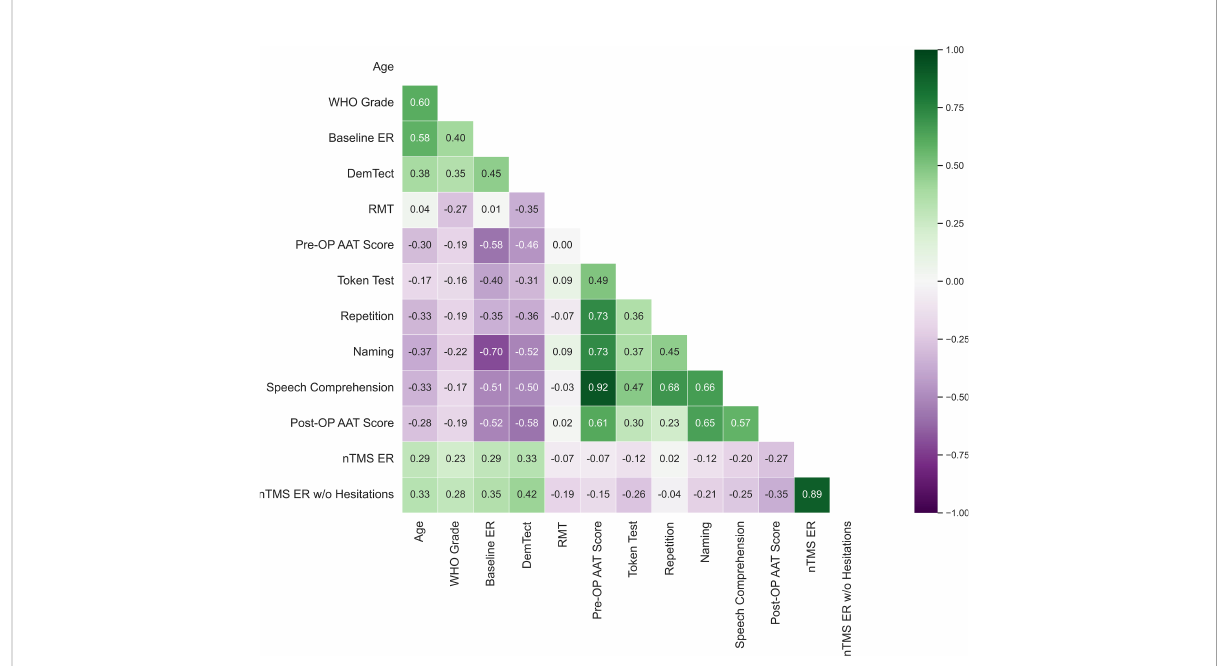
FIGURE 9 Bivariate correlation analysis between clinical and nTMS parameters. Each number represents the Pearson ’ s correlation coef fi cient between listed clinical parameters. Pre-OP AAT scores were collected on the day of the nTMS mapping and post-operative AAT scores were collected